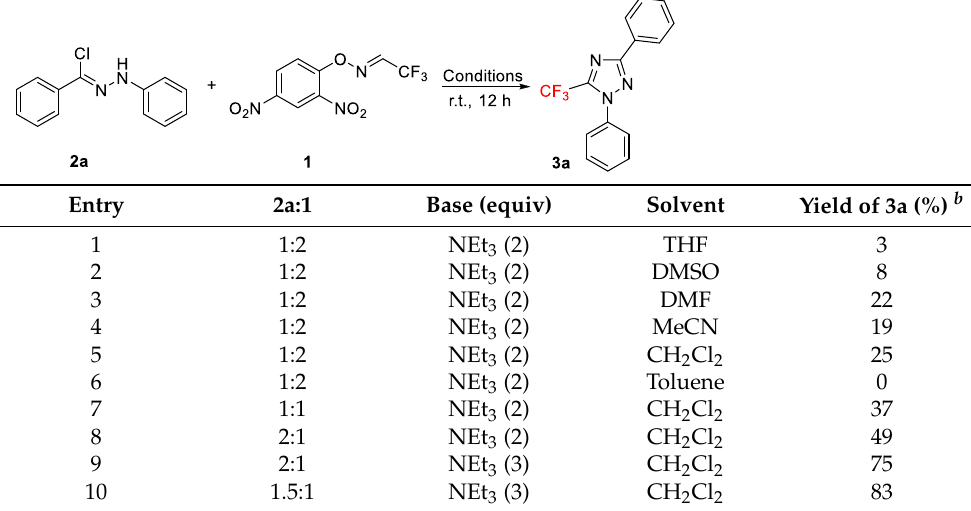
Table 1. Optimization of the reaction conditions a .